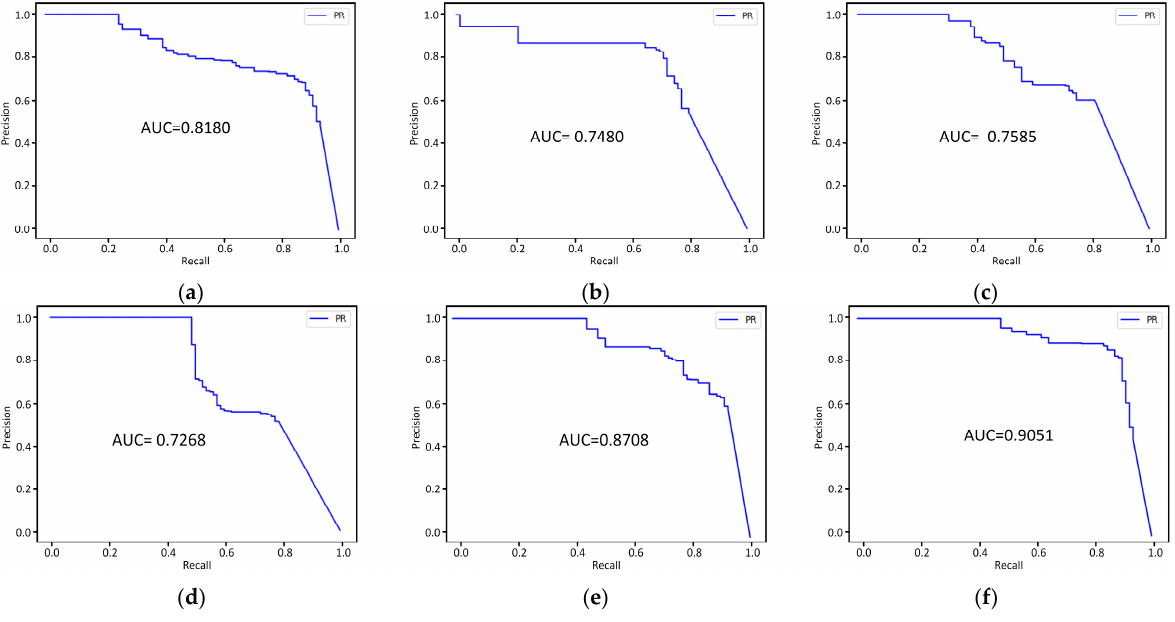
Figure 11. Precision-recall curves graphs during testing stage before and after Mask R-CNN opti- mization: ( a ) Model 1; ( b ) Model 2; ( c ) Model 3; ( d ) Model 4; ( e ) Model 5; ( f ) Model 6.